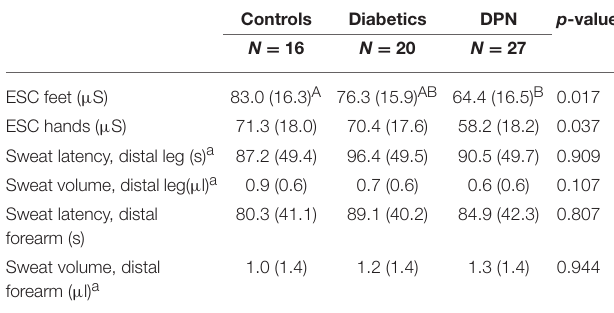
TABLE 2 | Sudomotor function of study subjects.